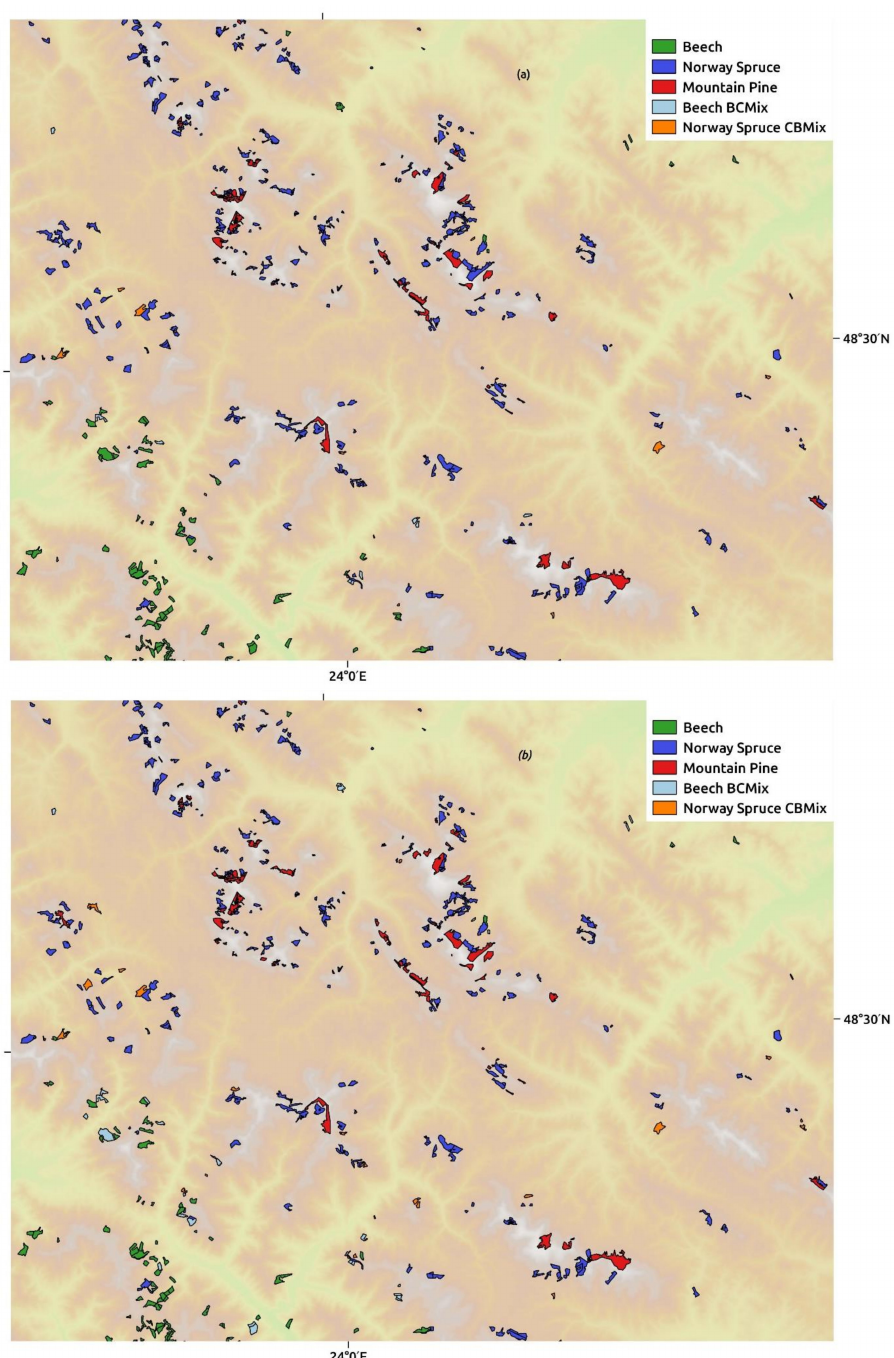
Figure 2. Map of Old-Growth Forest tree species based on ( a ) the Random Forest classifier using all features for combined summer and autumn images ( b ) WWF ground survey. Beech BCMix is dominant beech with at least 20% conifer species, Norway Spruce CBMix is dominant Norway spruce with at least 20% broadleaf